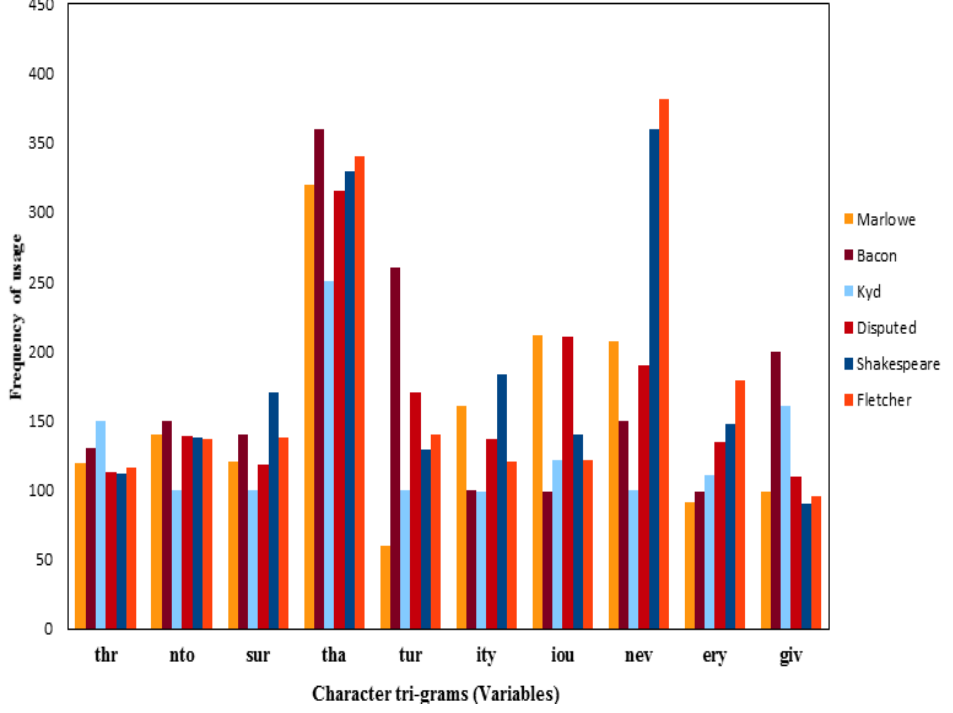
Figure 27. Characters tri-gram centroid-based bar plot for all the authors tested. The centroids for the cluster texts of interest in D FW , D bigram , and D trigram were calculated and the results are shown in Figures 28–30